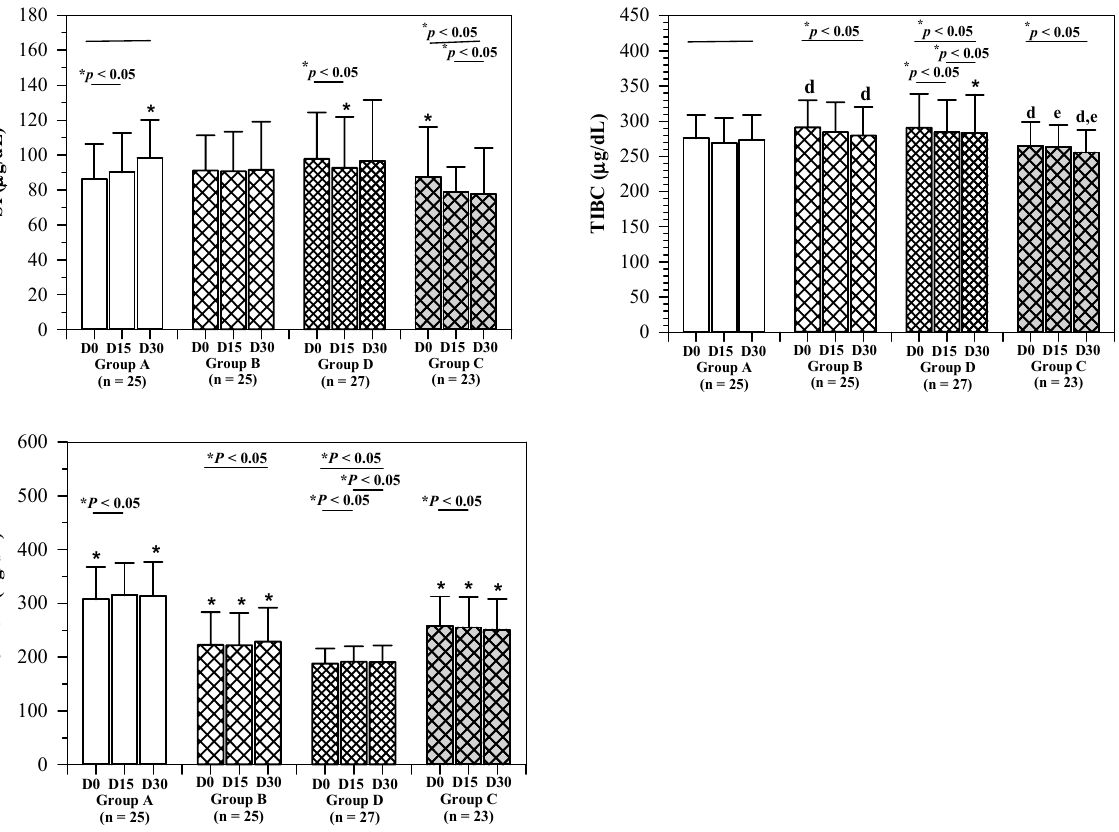
Figure 4. Changes in levels of serum iron, total iron-binding capacity and ferritin of elderly subjects. Non-anemic elders consumed the WR drink (2 mg iron/100 mL serving) (group A), IR drink (15 mg iron/serving) (group B) and IR drink (27 mg iron/100 mL serving) (group D), and anemic elders consumed the IR drink (15 mg iron/100 mL serving) (group C) for 30 days and blood samples were collected for analysis of iron parameters. Data are expressed as mean ± SD values with the exception of ferritin, which is expressed as mean ± SEM values. * Shapiro–Wilk test ( p < 0.05). d,e,f Comparisons between D0 and D15, D0 and D30, D15 and D30 for normal distribution by paired Student’s t-test ( p < 0.05) after using repeated measure ANOVA ( p < 0.05). Abbreviations: Ft = ferritin, SI = serum iron, TIBC = total iron-binding